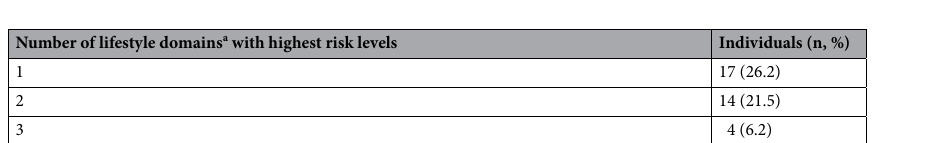
Table 3. Number of areas with the highest risk level (3 or 4) (only areas to be treated with lifestyle improvement). a Physical activity, food, alcohol, tobacco, BMI, WHR, cholesterol, blood pressure.